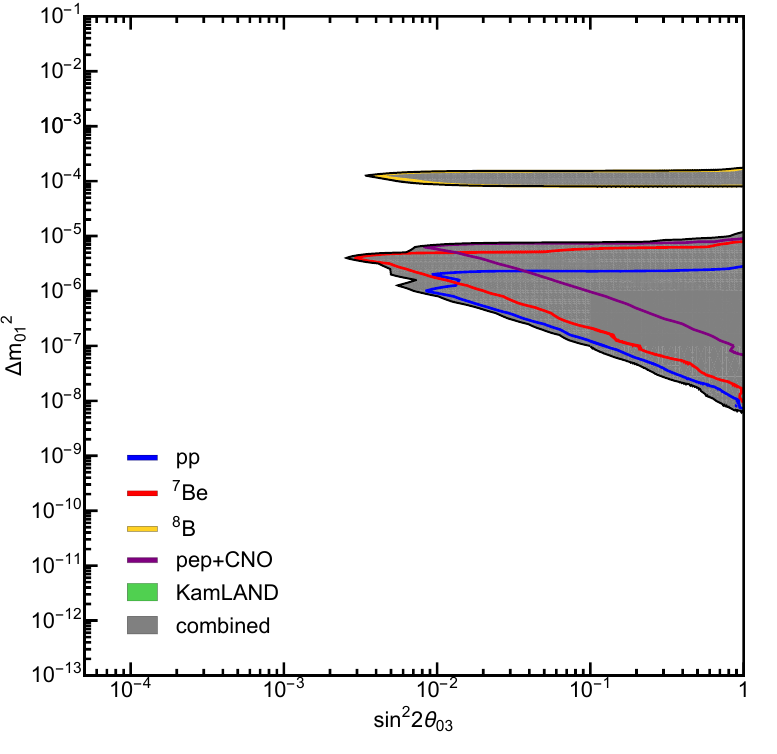
Figure 10 . Same as in figure 8, except for θ 03